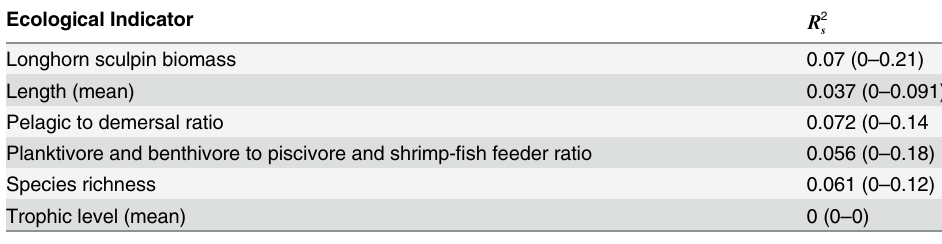
Table 3. Mean and range of model performance by ecological indicator, R 2 s . Ecological